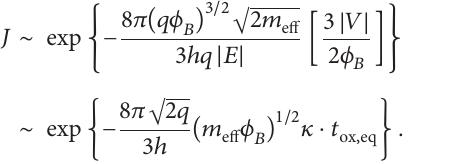
0.750.80.850.90.951